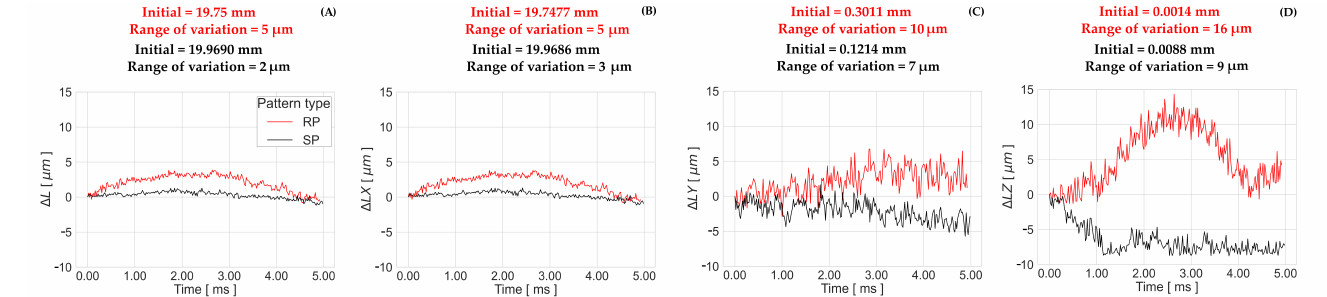
Figure 20. ( A ) ∆ L , ( B ) ∆ LX , ( C ) ∆ LY , and ( D ) ∆ LZ for the best-performing patterns (RP 06 and SP 02) under dynamic conditions (03 height, 50000